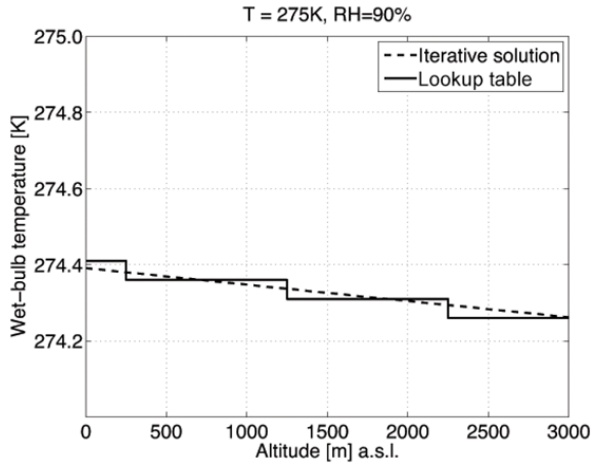
Figure 3. Comparison of iteratively calculated wet-bulb tempera- ture to the results of the lookup table approach implemented in ES- CIMO.spread